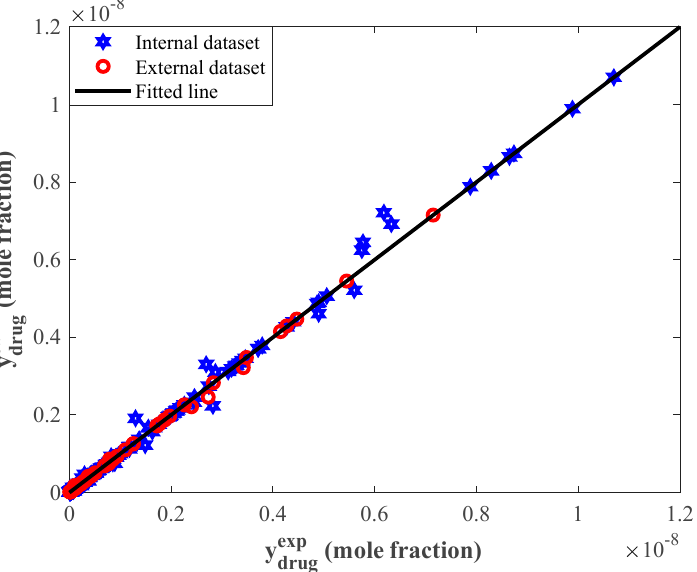
Figure 2. Correlation between experimental and calculated solubilities of the studied anticancer drugs.